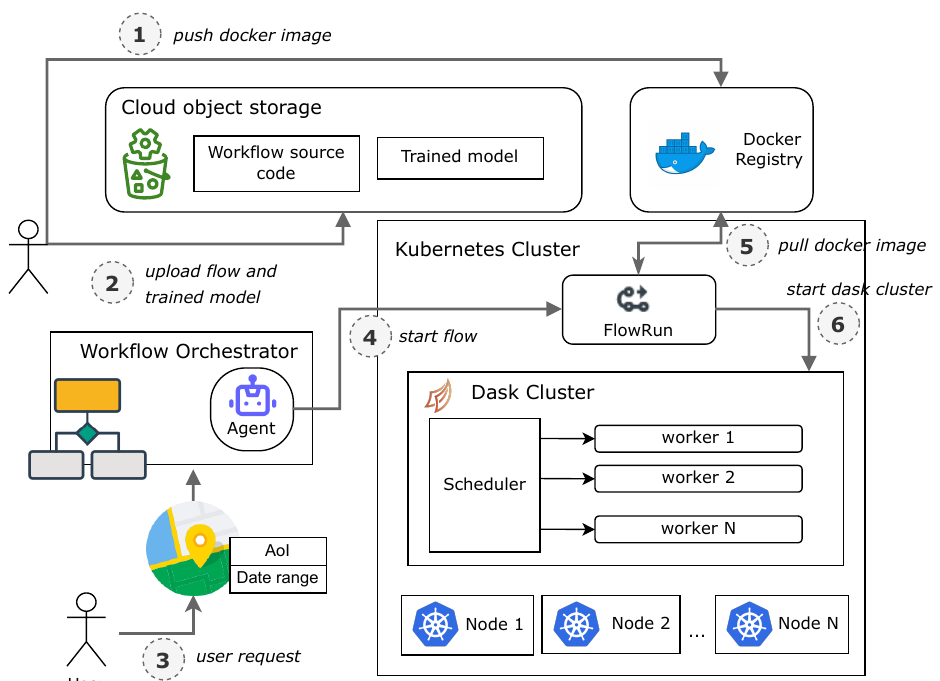
Figure 9. Flow execution process for the imperviousness map generation. A Docker image stores library dependencies. The model, weights and flow code are stored in object-based storage. During flow execution, the orchestrator pulls the image from the Docker registry and using it starts a Dask cluster. Finally, the prediction flow is executed on the Dask